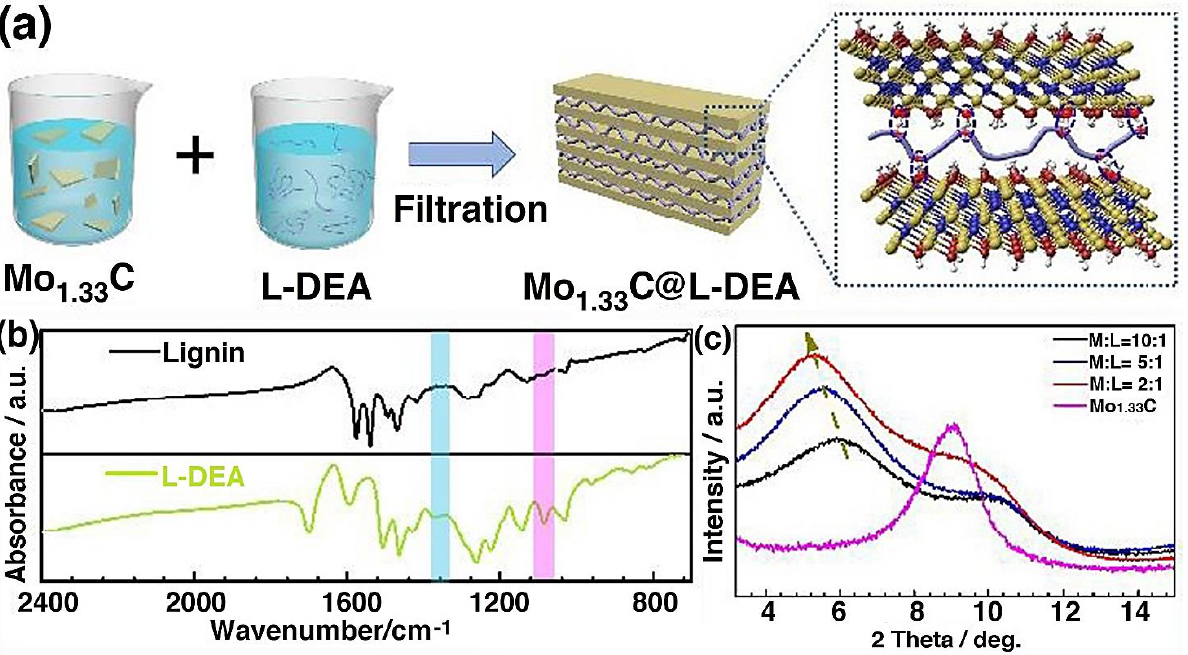
Figure 7. MXene/L ‐ DEA nanocomposites. ( a ) Preparation sketch of the Mo1.33C@L ‐ DEA composite Figure 7. MXene/L-DEA nanocomposites. ( a ) Preparation sketch of the Mo 1.33 C@L-DEA composite electrode. ( b ) FT ‐ IR spectra of the lignin and L ‐ DEA. ( c ) XRD patterns of the hybrids and pure electrode. ( b ) FT-IR spectra of the lignin and L-DEA. ( c ) XRD patterns of the hybrids and pure Mo 1.33 C films. Adopted with permission from [136]. Mo 1.33 C films. Adopted with permission from